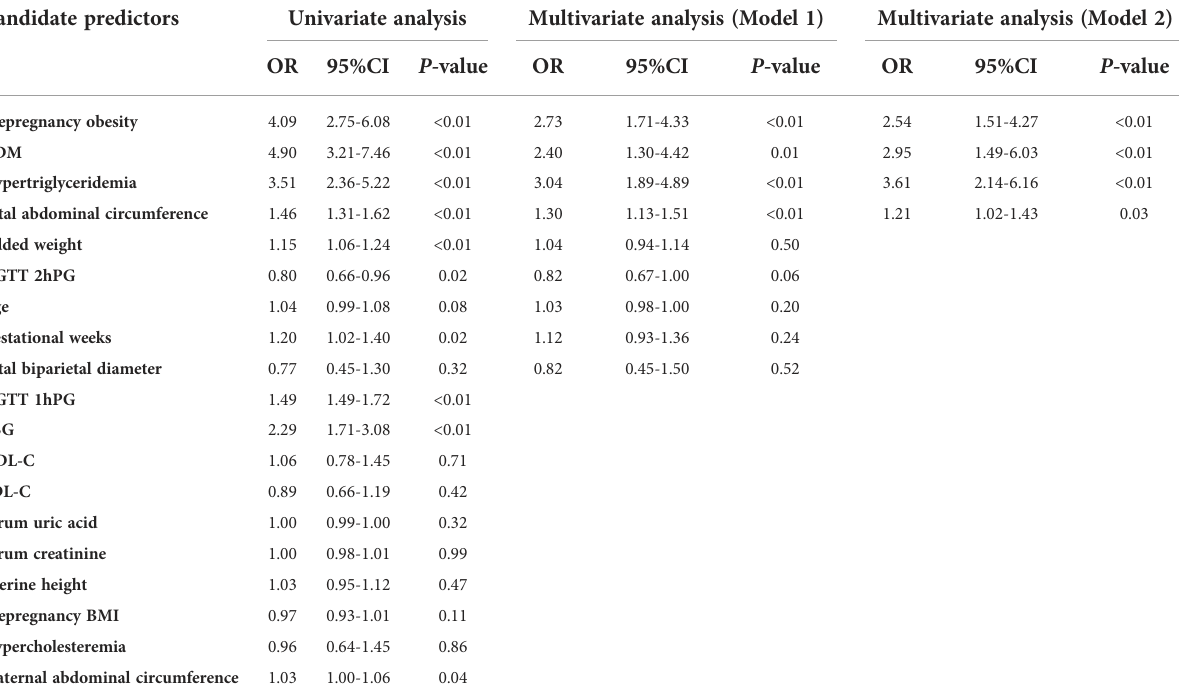
TABLE 2 Logistic regression analysis of the candidate predictors for macrosomia.